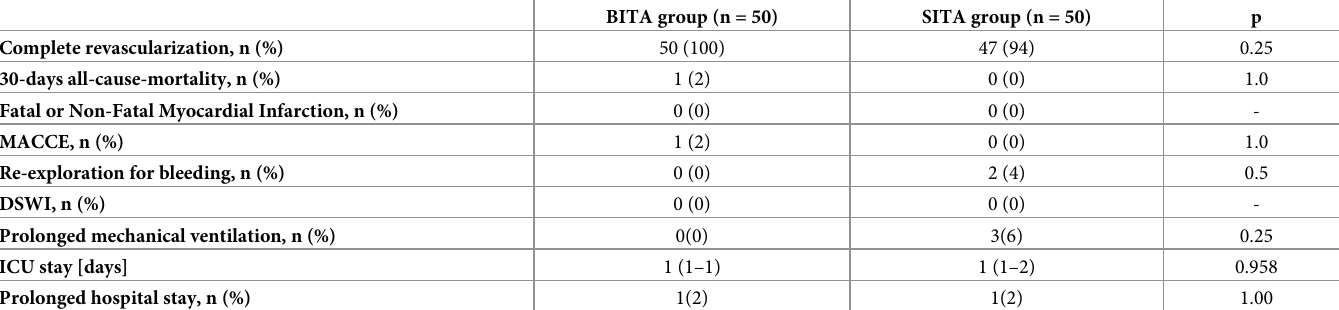
Table 3. Postoperative